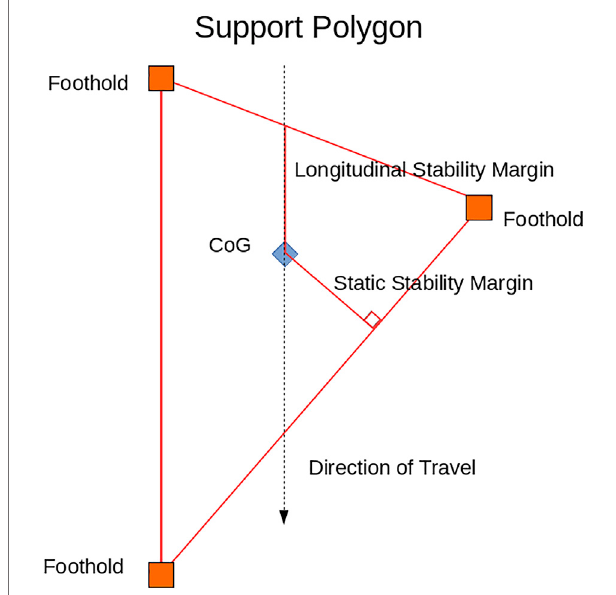
FIGURE 5 | Visualization of the support polygon and the static stability margin and longitudinal stability